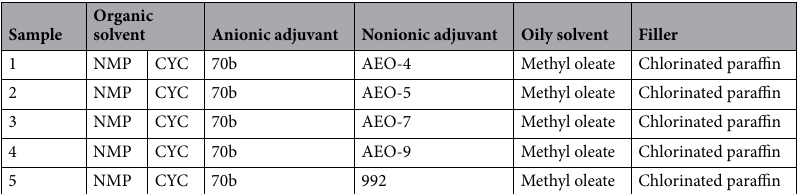
Table 3. Ultra-low-volume formulations used in this study.